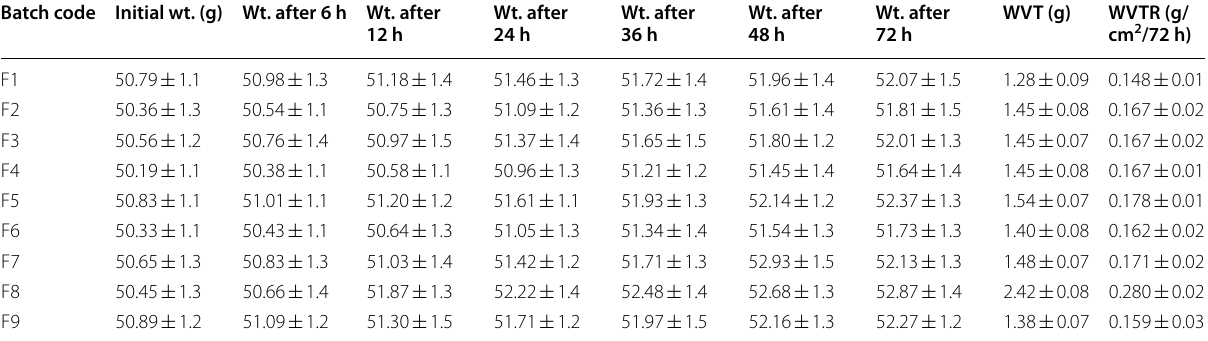
Wt. after 12 h 24